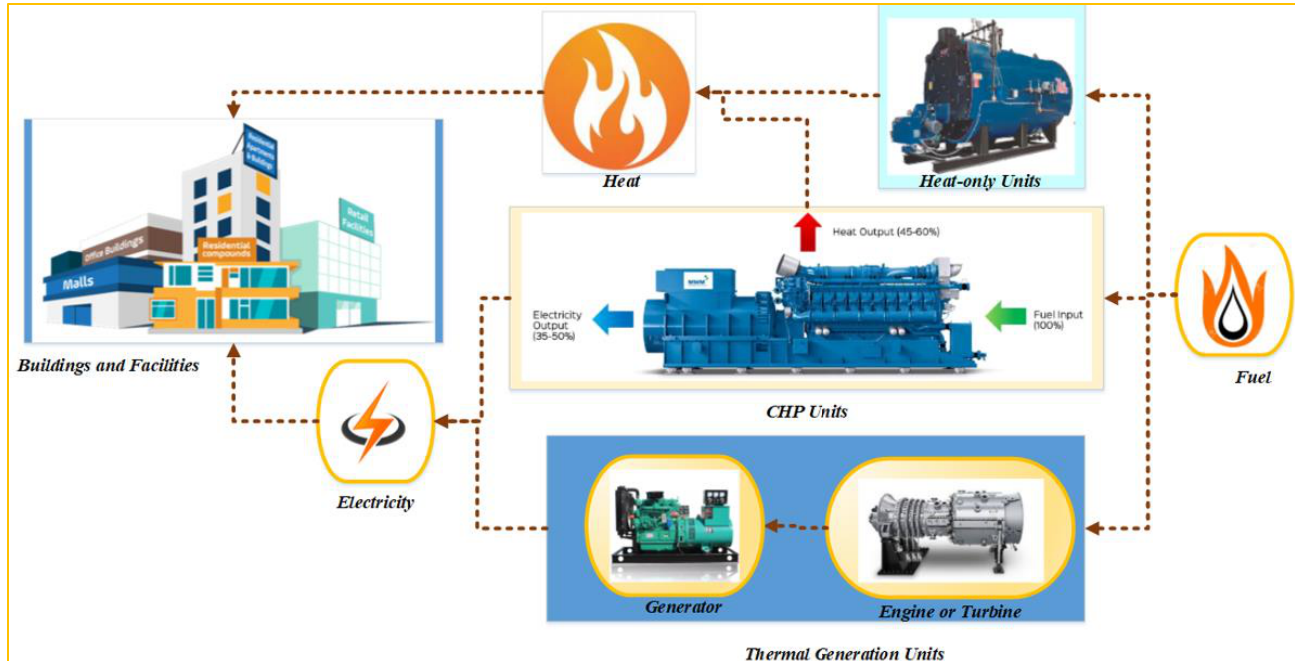
Figure 1. Main participants in the EDM integrating CHP units.